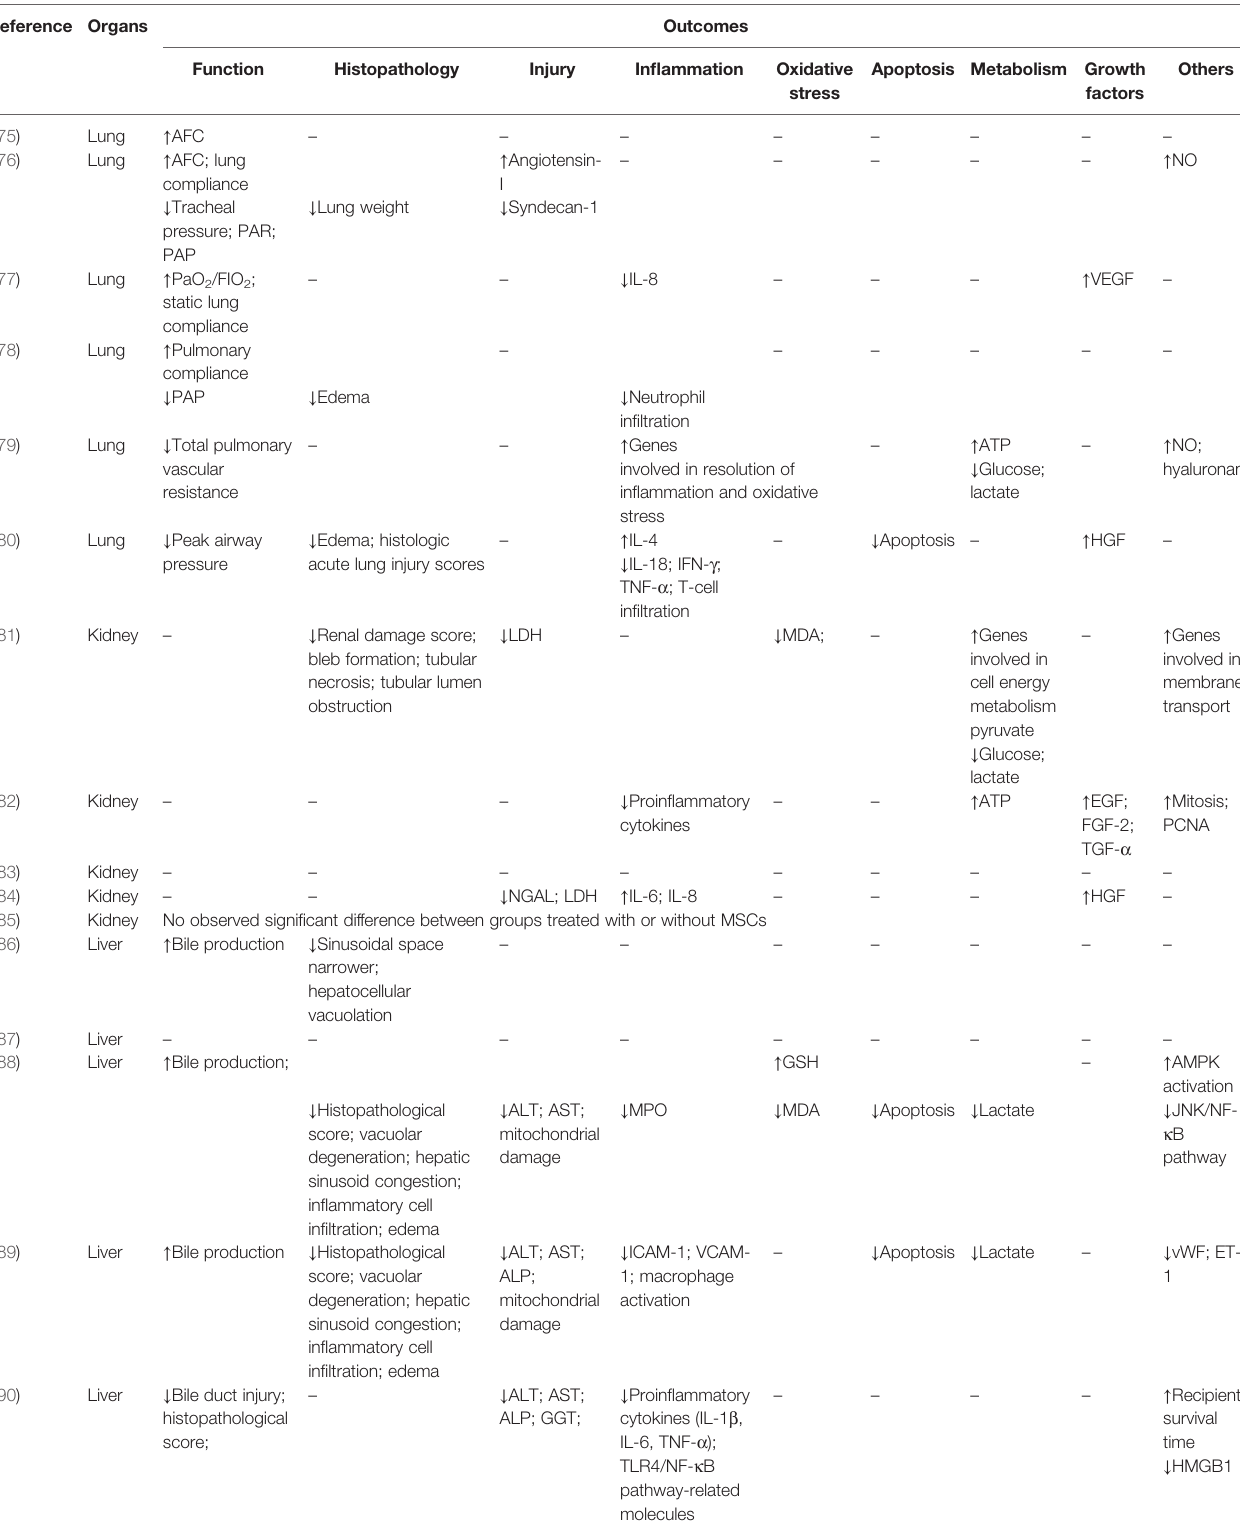
TABLE 2 | The therapeutic effects of MSCs combined with machine perfusion on organ